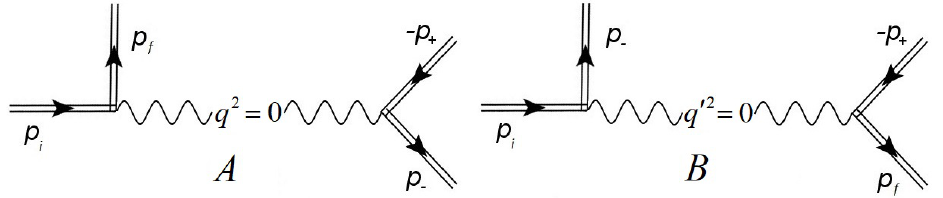
Figure 1. Feynman diagrams of the process of electron–positron pairs production when electrons collide with the field of an X-ray pulsar. The solid lines correspond to the Volkov functions of the initial and scattered electrons with 4-momenta p i and p f and to the particles of the pair with 4-momenta p ± , the wavy lines correspond to the intermediate photons. Channels A and B are (cid:16) (cid:17) p f ⇐⇒ p − distinguished by replacement of electrons states